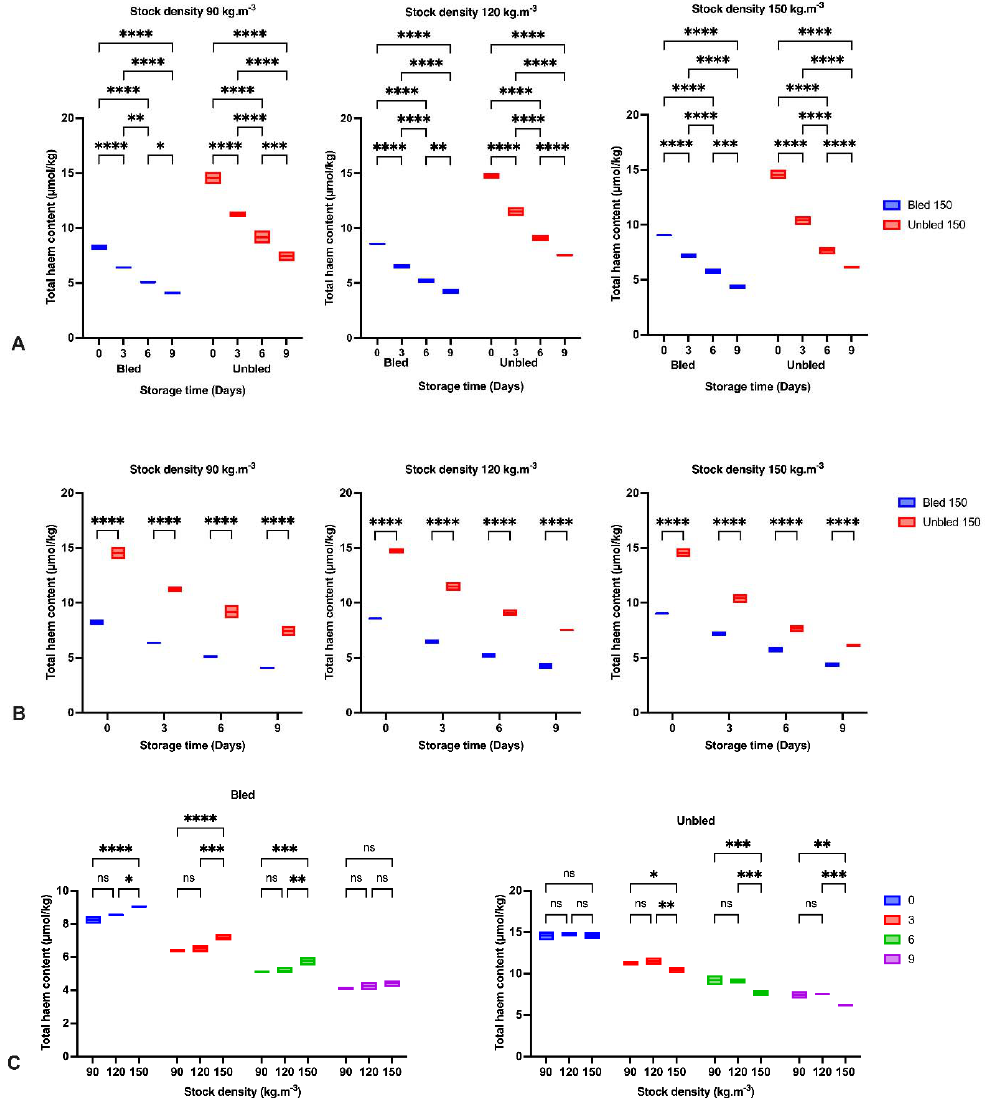
Figure 4. Total heme content: ( A ) During the storage time (0, 3, 6 and 9 days) in bled and unbled groups at different stock densities (90, 120 and 150 kg.m _3 ); ( B ) In bled and unbled groups at each storage time (0, 3, 6 and 9 days) and at different stock densities (90, 120 and 150 kg.m _3 ); ( C ) In different stocking densities (90, 120 and 150 kg.m _3 ) during storage time (0, 3, 6 and 9 days) in bled and unbled groups; ( p < 0.05, Tukey’s multiple comparisons test; ns: non ‐ significant; * p < 0.05; ** p < 0.01; *** p < 0.001; **** p < 0.0001). Box plots showing line at mean. Box plots showing the line at upper quartile, lower quartile and at the mean.